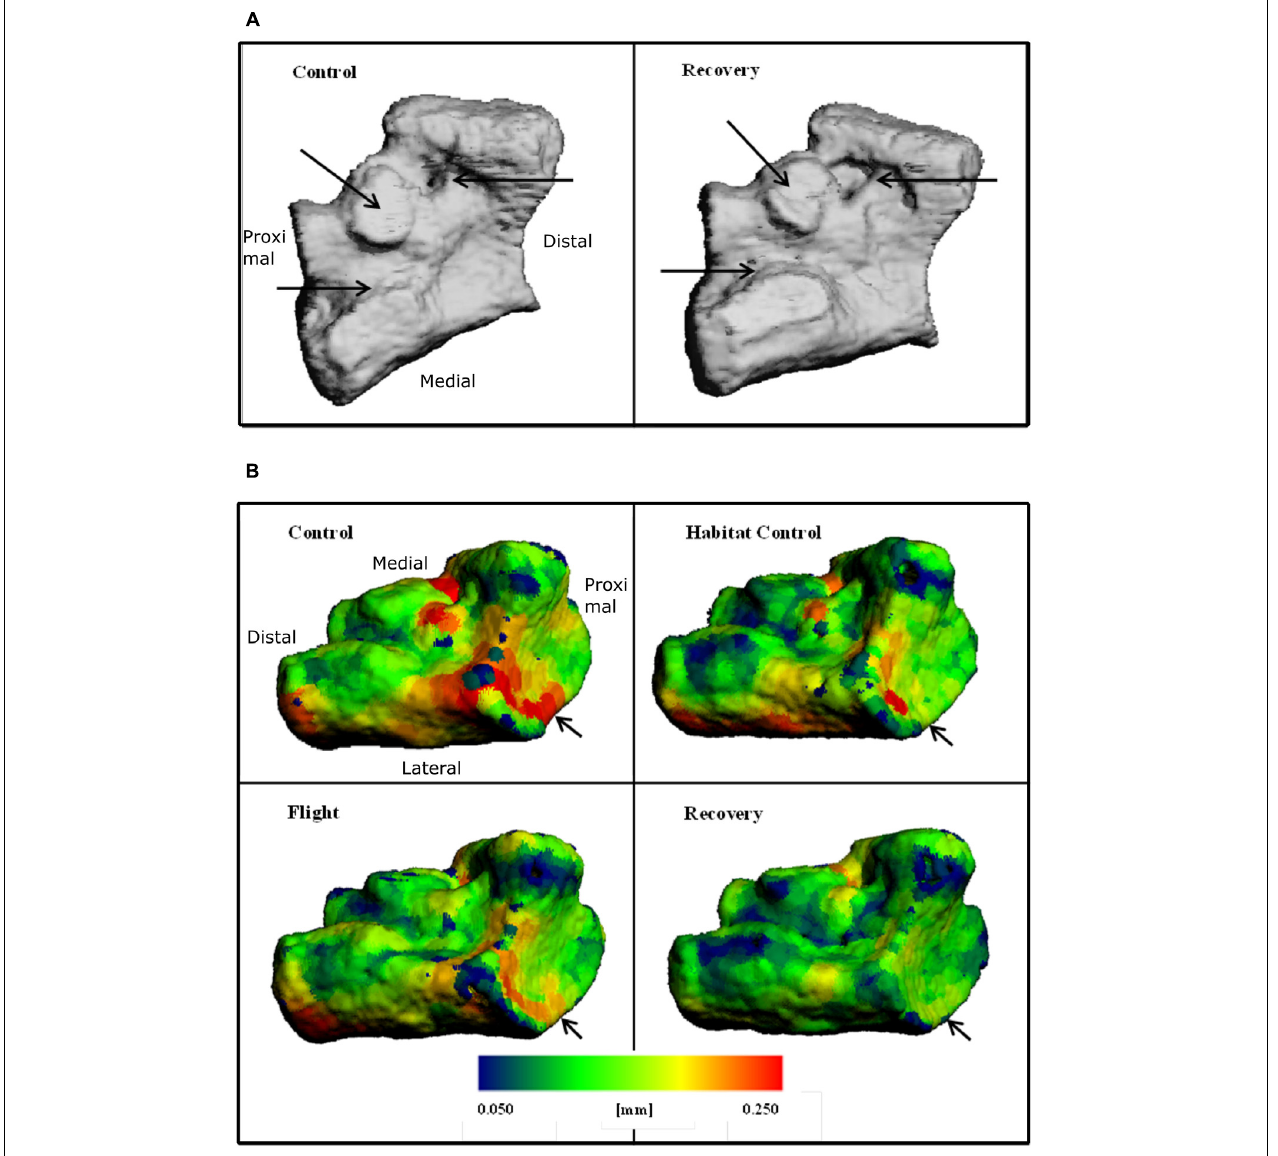
FIGURE 4 | Three-dimensional reconstructions of the navicular, illustrating (A) BS and regions of erosion (indicated via black arrows) for Control and Recovery and (B) color maps for Ct.Th, blue = thinnest (0.050 mm) and red = thickest (0.250 mm) for: Control; Habitat control; Flight; and Recovery. Black arrows indicate areas of greatest change at